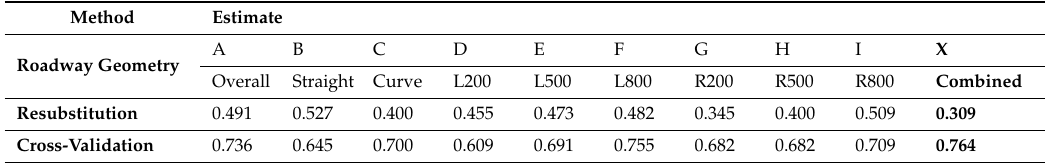
Table 3. Risk estimate of predicted classification of the CART